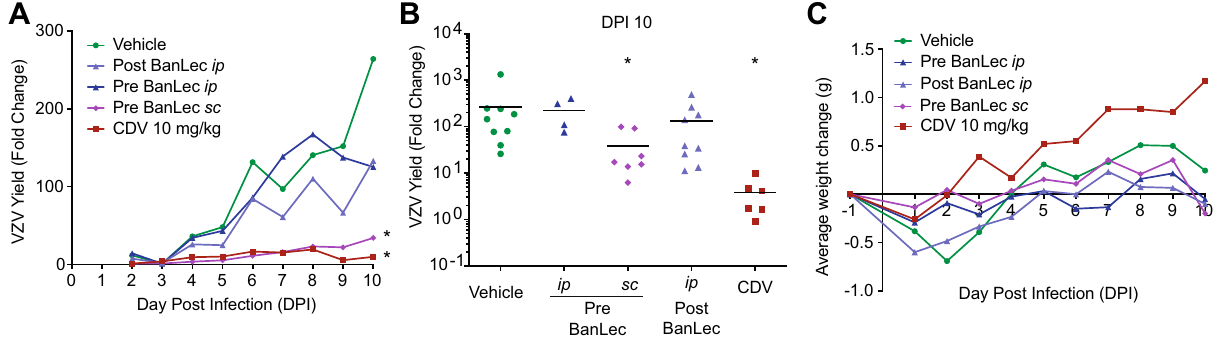
Figure 7. H84T BanLec evaluation in NuSkin mice infected with VZV. NuSkin mice were implanted with a single subcutaneous xenograft of adult human skin and xenografts were inoculated 3–4 weeks later with VZV by intraxenograft injection and scarification. Mice were treated with 50 mg/kg/day H84T BanLec by subcutaneous ( sc ) or intraperitoneal ( ip ) routes given 6 h pre-inoculation (−6 HPI) and on DPI 4 and 8 to the Pre-BanLec groups, or by the ip route on DPI 3 and 7 to the Post-BanLec group. Cidofovir was administered daily by ip injection from DPI 3–9. ( A ) VZV yield was measured by bioluminescence and the fold change calculated as the Total Flux on each day divided by the Total Flux on DPI 2 or 3 (the lowest value for that mouse). Lines represent the average VZV yield per group. ( B ) VZV yield on DPI 10 was analyzed for statistical significance where each symbol represents one mouse, and the bar is the mean of the group. (*) Signifies statistical significance between the vehicle and a treatment group ( p < 0.05, one-way ANOVA, Dunnett’s post hoc test). ( C ) Mouse weights were measured daily, and the lines show the average weight change for each group from the onset to conclusion of the study. N = 4–12 mice per